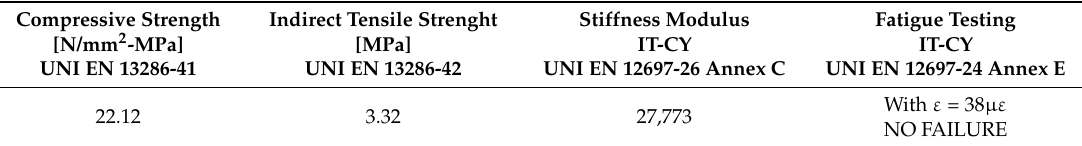
Table 1. Laboratory RTM’s main results.